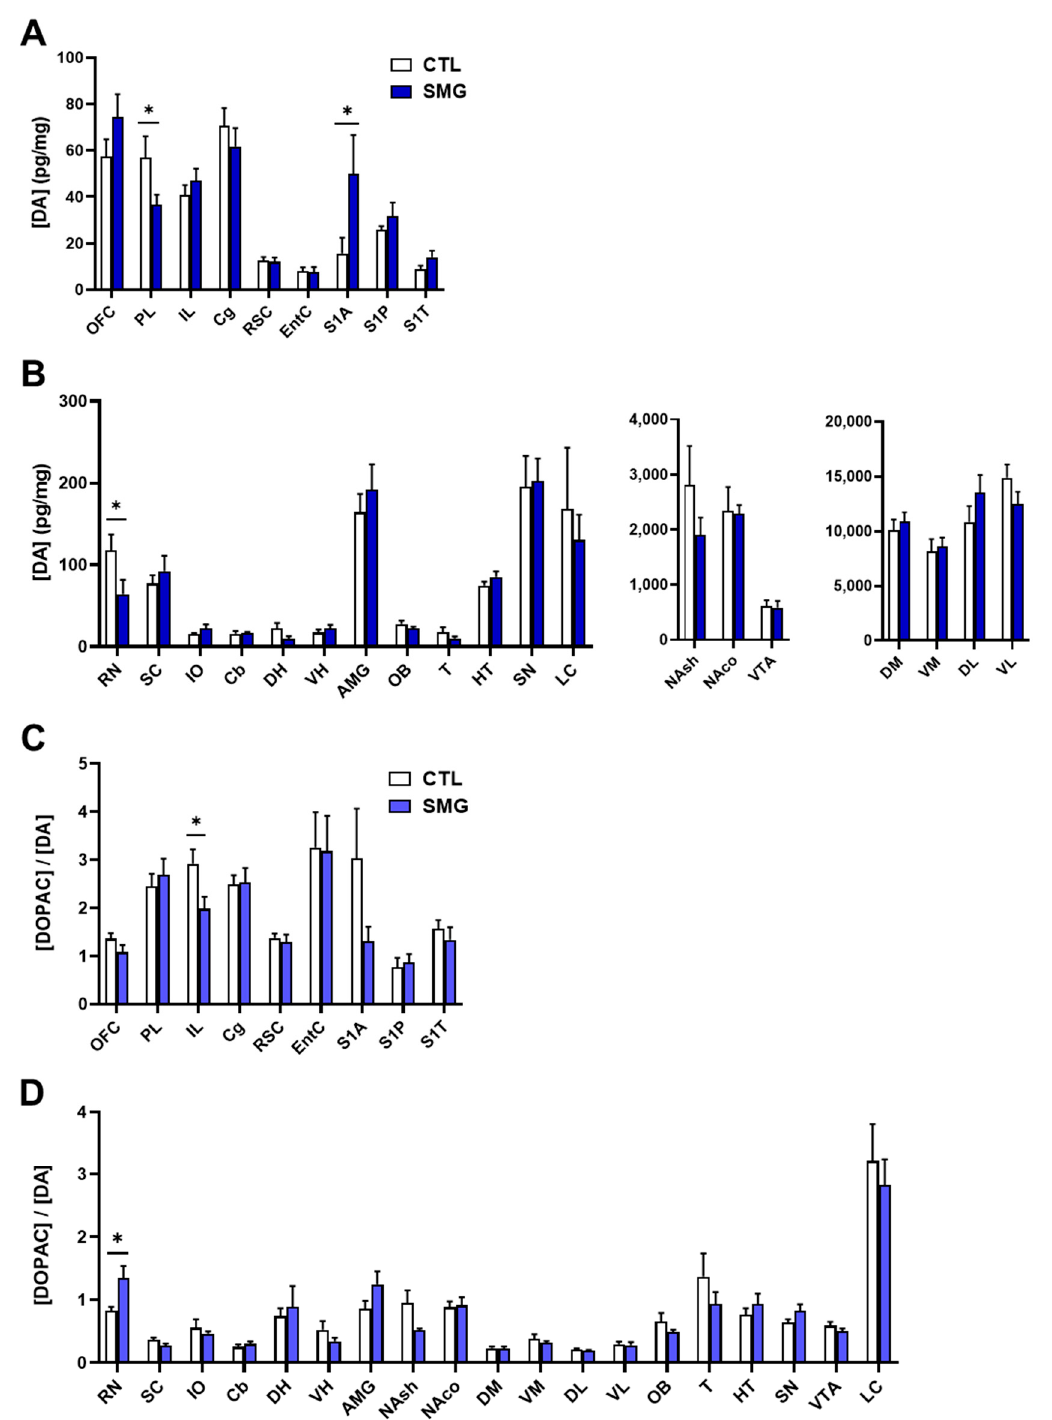
Figure 4. Effect of the SMG on the neurochemistry of the DA system in the brain. DA concentration in pg/mg of tissue for each group is shown in sampled cortical ( A ) and sub-cortical ( B ) brain regions. The ratio of the DOPAC concentration relative to DA concentration is reported in sampled cortical ( C ) and sub-cortical ( D ) brain regions. All data are presented as mean ± sem ( n = 12 rats/group). * p < 0.05, significant difference between SMG and CTL group (Mann–Whitney test).